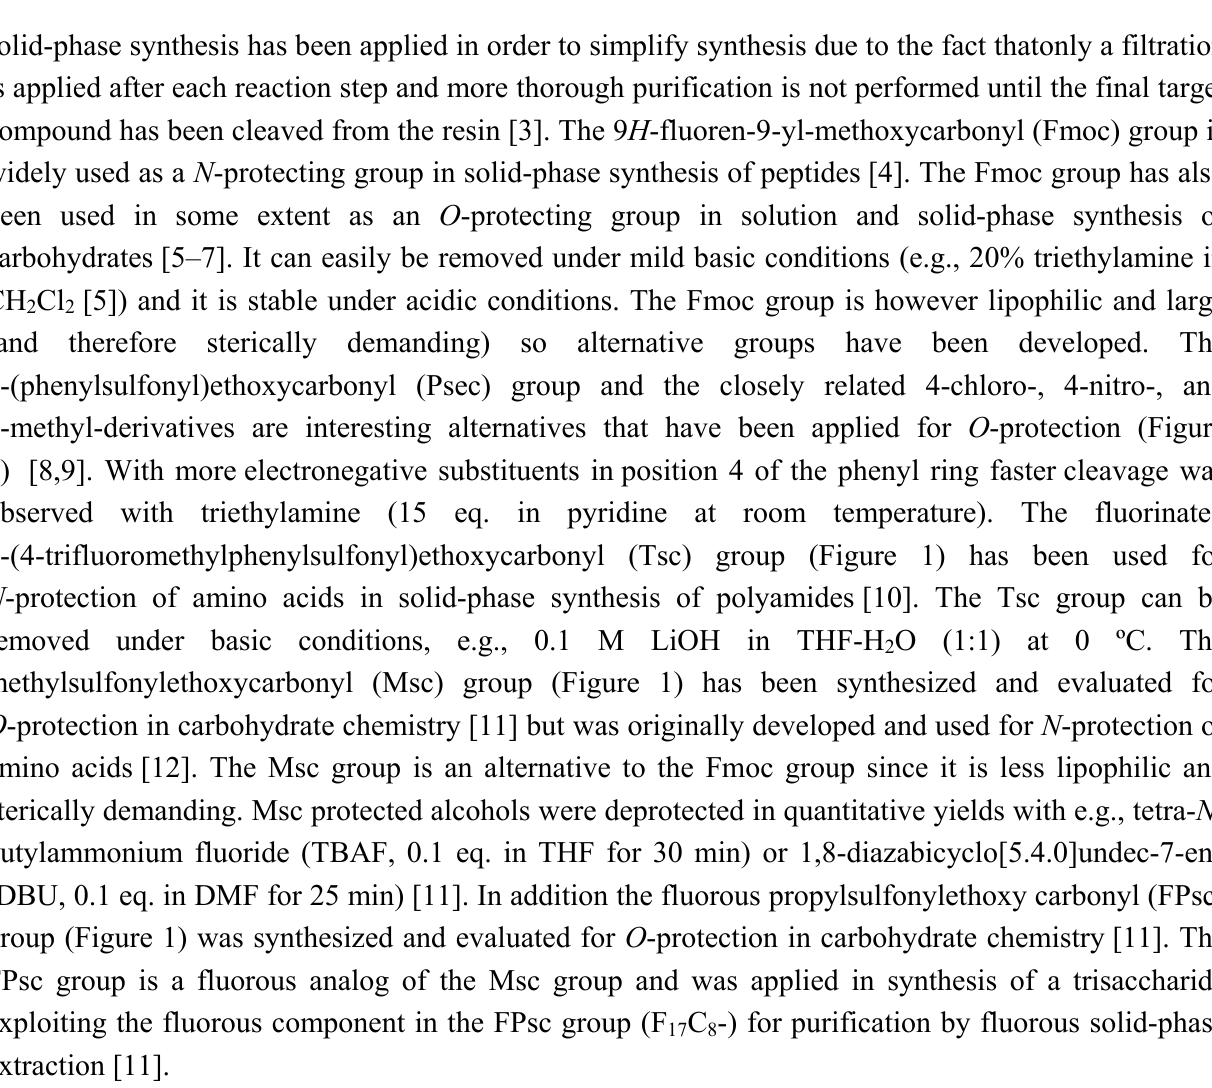
Figure 1. The Psec, Tsc, Msc, and FPsc protecting